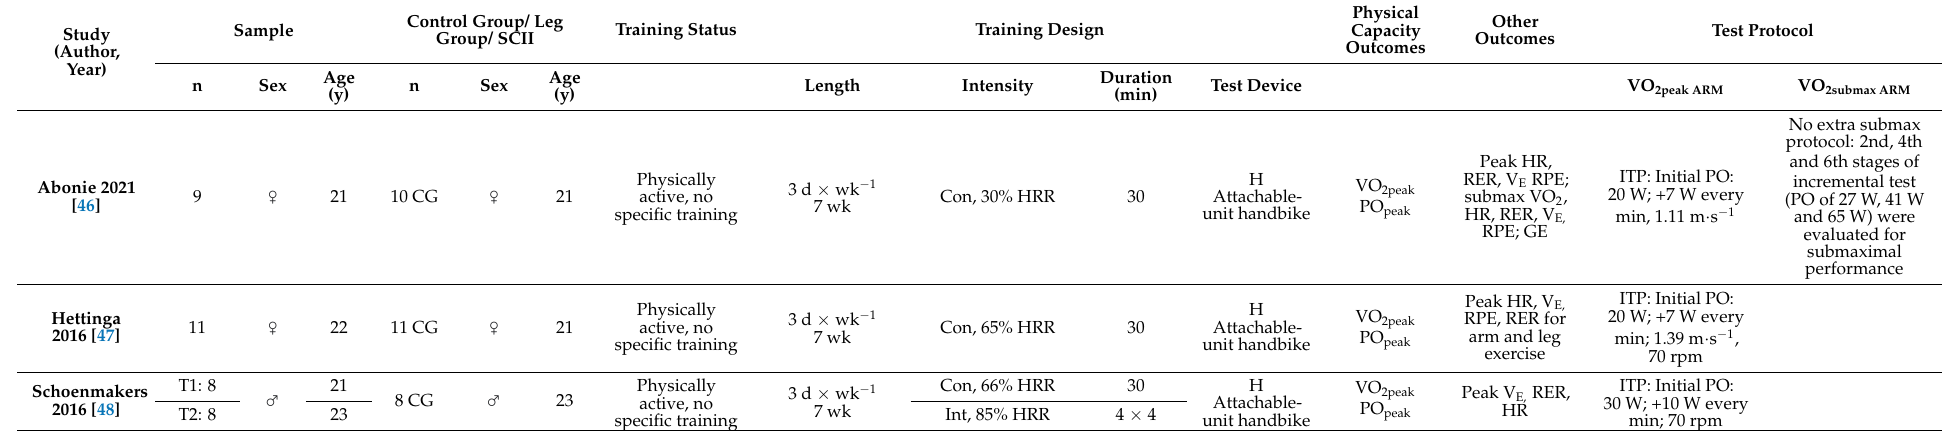
Table 3. Characteristics of studies evaluating the effects of handcycle exercise (HCE) on aerobic